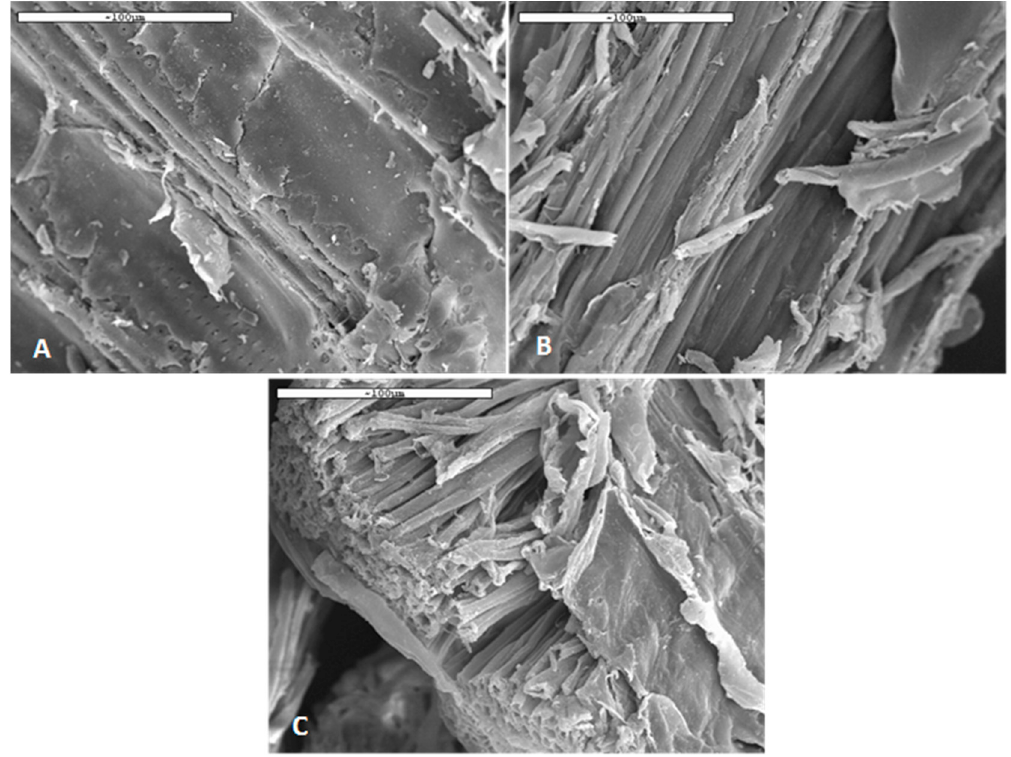
Figure 3. Scanning electron microscopy (SEM) images, bar scale of 100 μ m ( A ) untreated beechwood, ( B ) AC-1%H 2 SO 4 , and ( C ) EtOH-5.6%H 3 PO 4 .